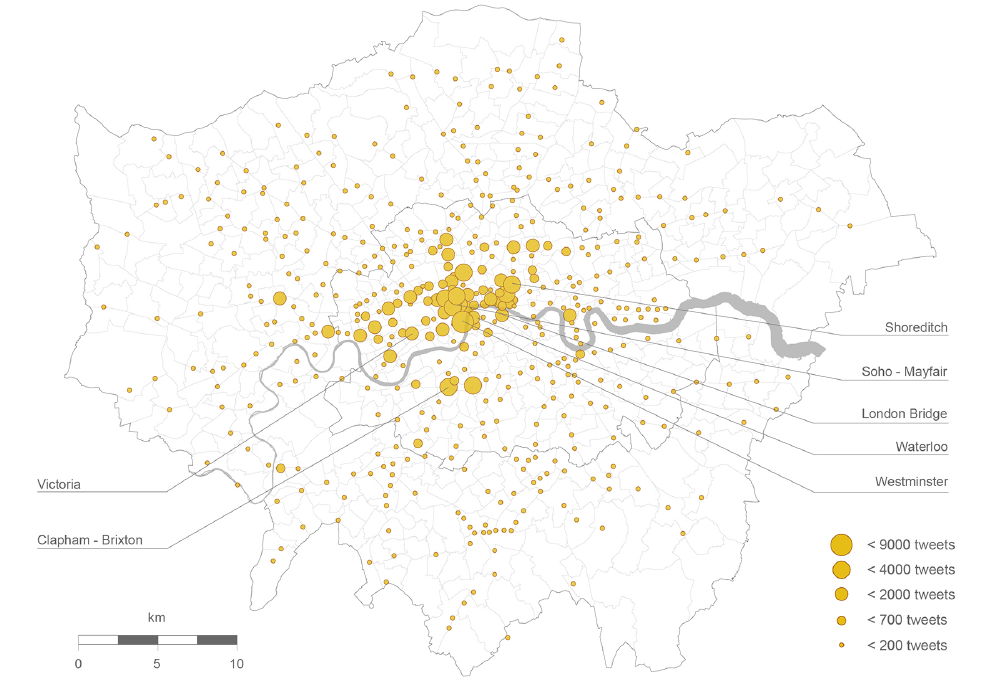
Figure 1: Number of tweets per area of